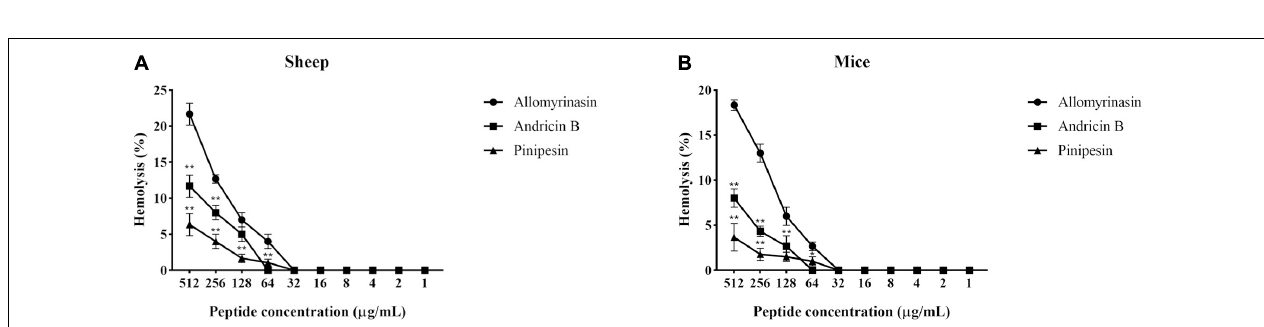
FIGURE 6 | The hemolytic reaction was observed in 4% suspensions of sheep (A) and mouse (B) erythrocytes treated with an increasing peptide concentration. All data recorded after incubation for 2 h are shown as the mean ± SD from the experiment performed in triplicate. Triton X-100 (2%) and phosphate-buffered saline (PBS) served as positive and negative controls, respectively. Statistically significance was performed in comparison with allomyrinasin (* p < 0.05; ** p < 0.01), using one-way ANOVA followed by Tukey’s analysis.